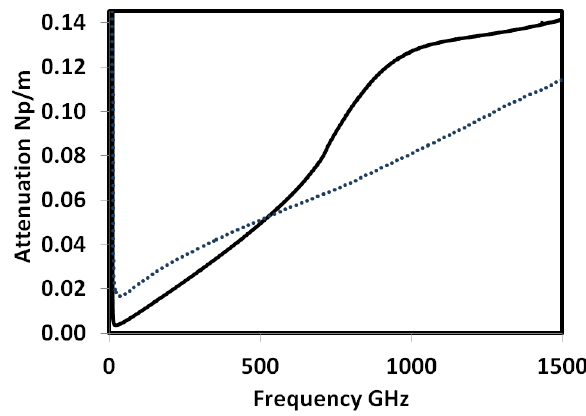
Figure 2: Attenuation of TE11 mode at frequency 0 to 1.5 THz in a Nb circular waveguide (with 8.1 mm radius), operating at 4.2 K (solid line) and room temperature (dotted line).